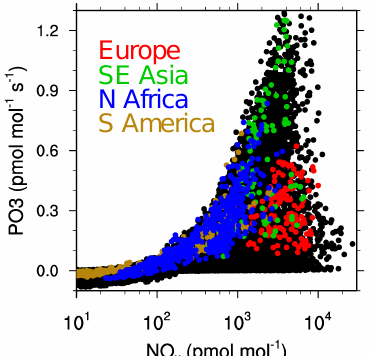
Figure 5. Dependency between NO x mixing ratios and net O 3 pro- duction. The black dots represent monthly mean values at ground level for the year 2010 of every individual grid box. The individ- ual colours indicate monthly average values during May–August (Northern Hemisphere) and November–February (Southern Hemi- sphere) for individual regions (defined as rectangular